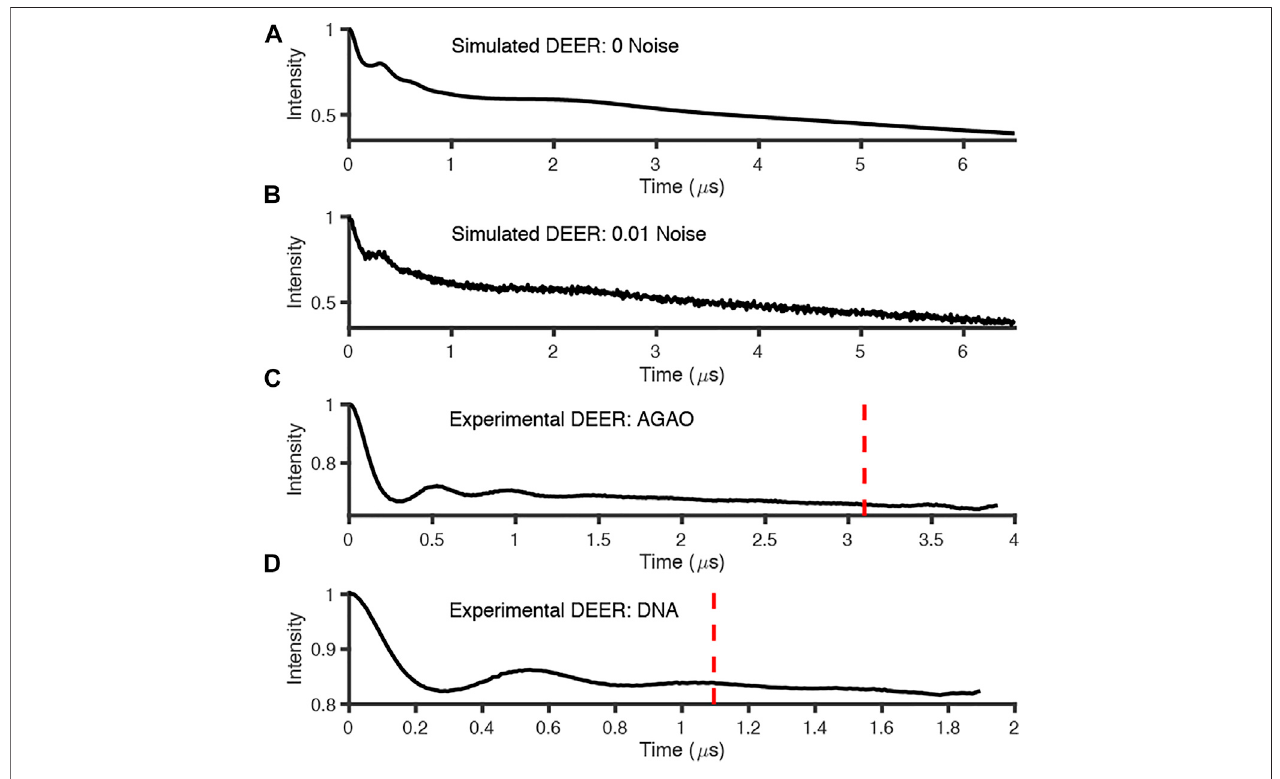
FIGURE 6 | Simulated and experimental DEER traces where red dotted line signi fi es 800 ns cut from end points; (A) simulated noiseless; (B) simulated noisy; (C) experimental AGAO; (D) experimental DNA measurements. Further details of the data sets in the main